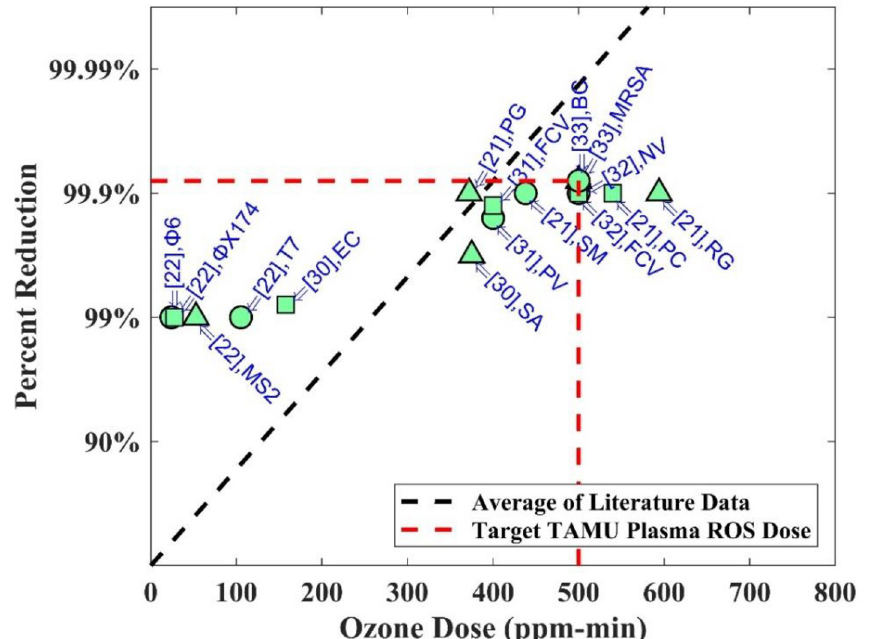
Fig 1. Graph of percent reduction (%) of strains and ozone dose